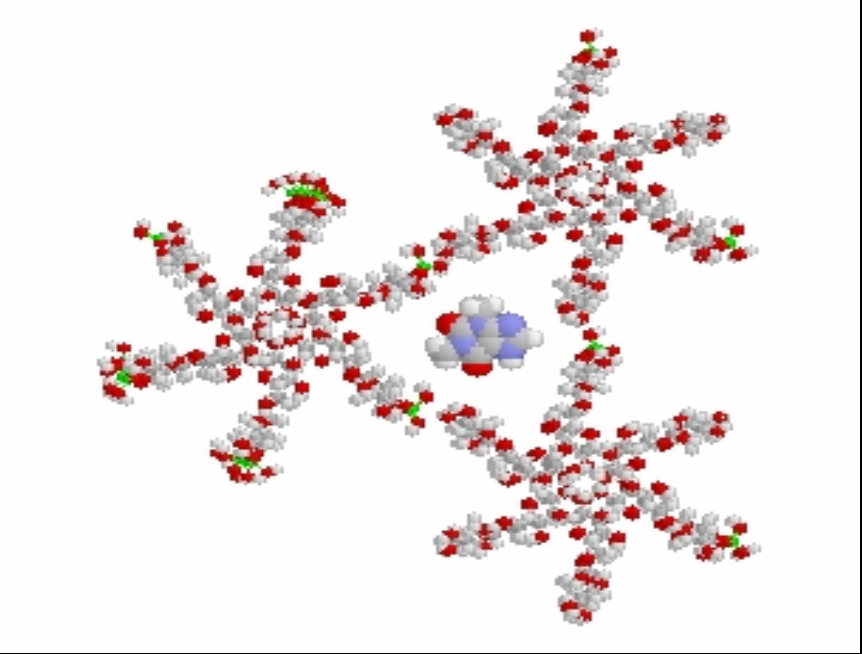
Figure 14. Proposed structure for Sclg/borax gel loaded with TPH, showing the channel obtained from the aggregation of three helices including a molecule of the model